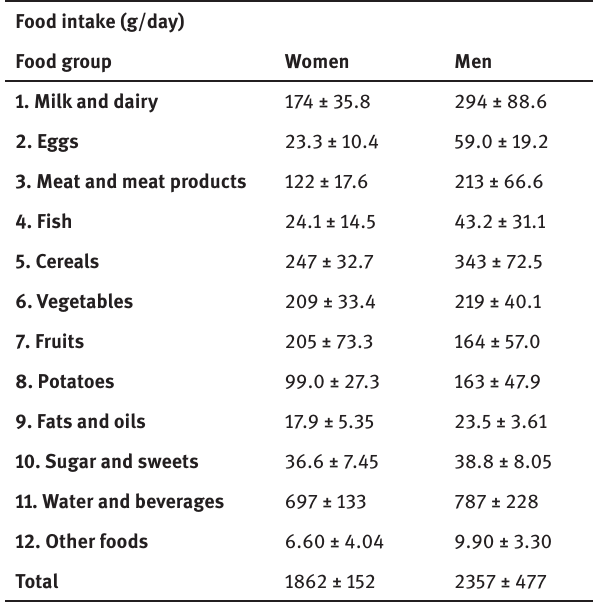
Table 1: Average daily intake of food by food group in the present study (3 years study